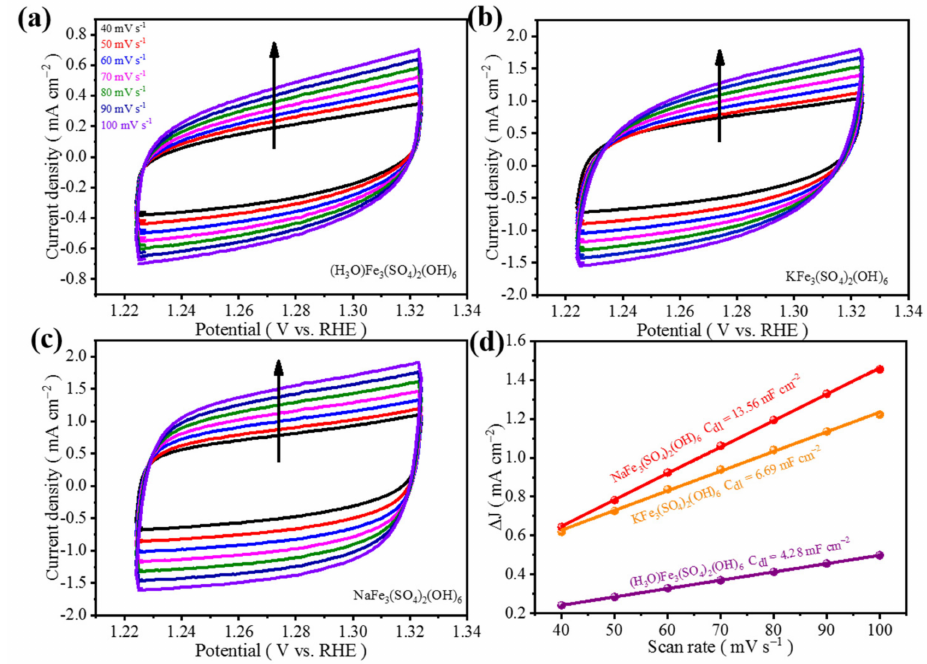
Figure 5. CV curves of ( a – c ) (H 3 O)Fe 3 (SO 4 ) 2 (OH) 6 , KFe 3 (SO 4 ) 2 (OH) 6 , and NaFe 3 (SO 4 ) 2 (OH) 6 at different scan rates, ( d ) C dl diagram of (H 3 O)Fe 3 (SO 4 ) 2 (OH) 6 , KFe 3 (SO 4 ) 2 (OH) 6 , and NaFe 3 (SO 4 ) 2 (OH) 6